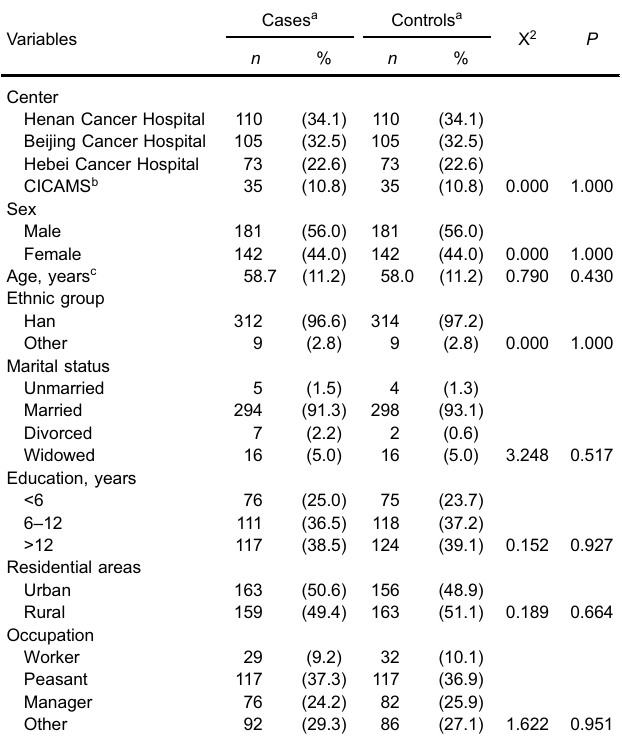
Table 1. Characteristics of 323 pancreatic cancer cases and 323 controls